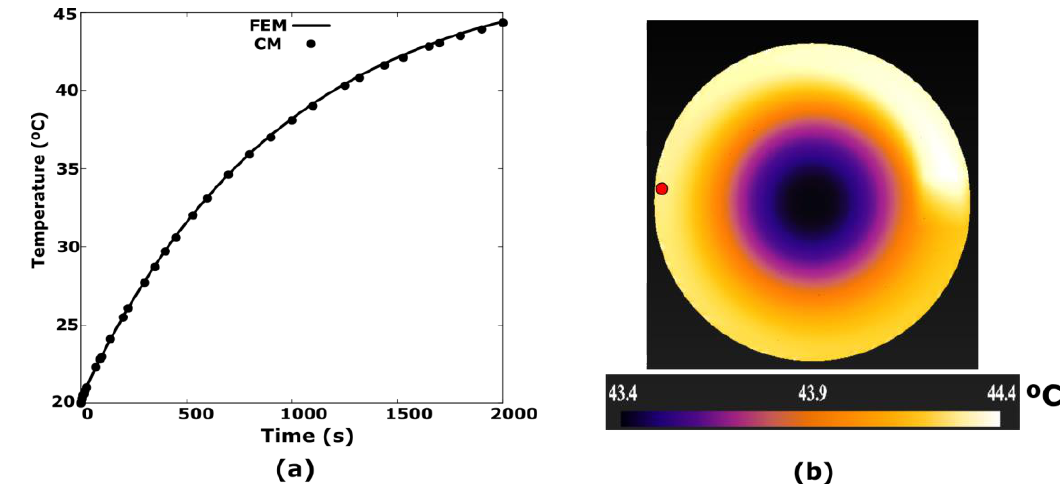
Figure 10. ( a ) Transient temperature regime at the red point, using CM and FEM with a uniform heat power density of 2 × 10 6 W / m 3 and w r = 15 rad / s; ( b ) The surface temperature distribution shown corresponds to t = 2000 s for the CM.